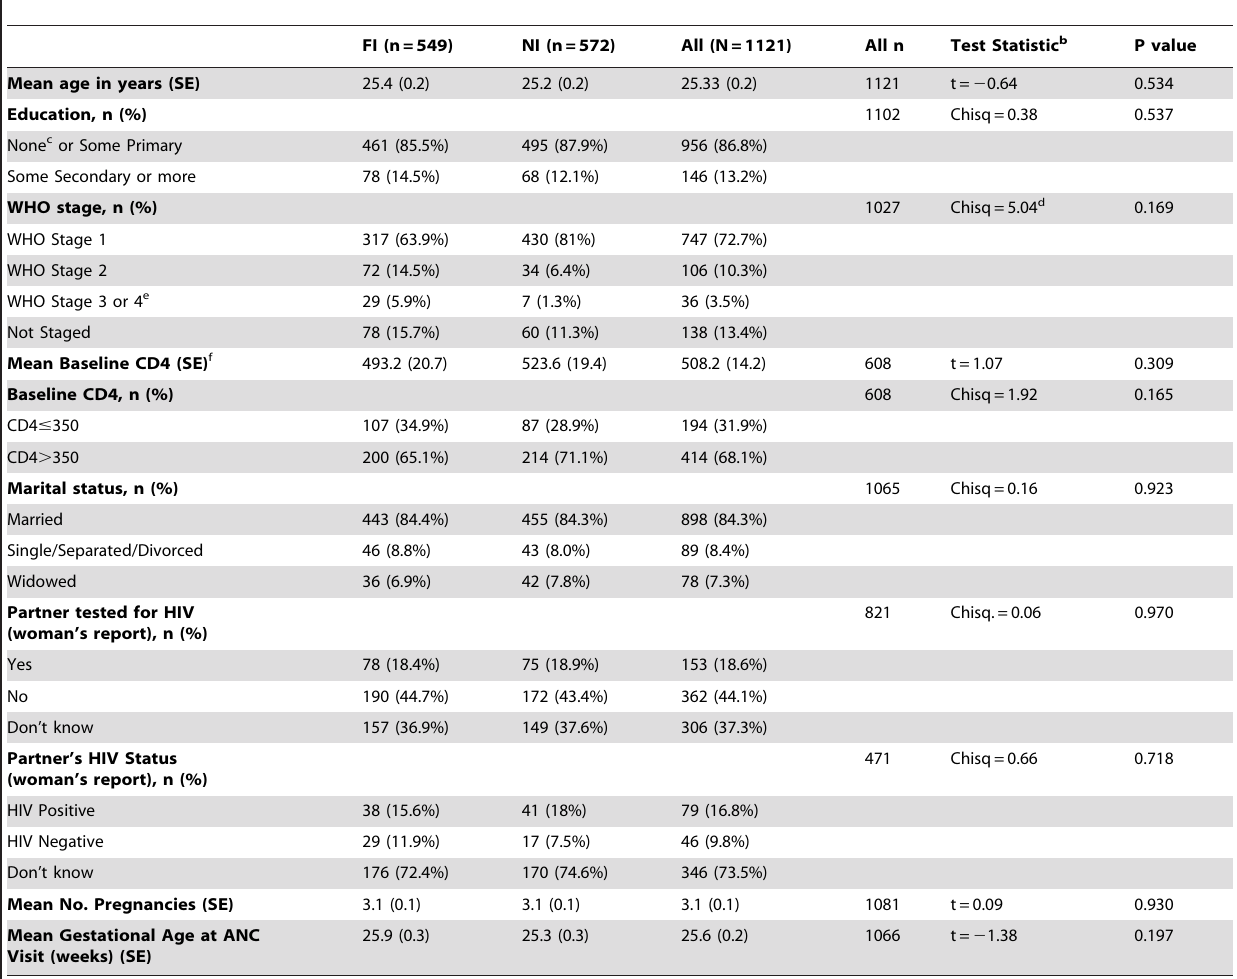
Table 2. Baseline characteristics of study participants (N =1121) a